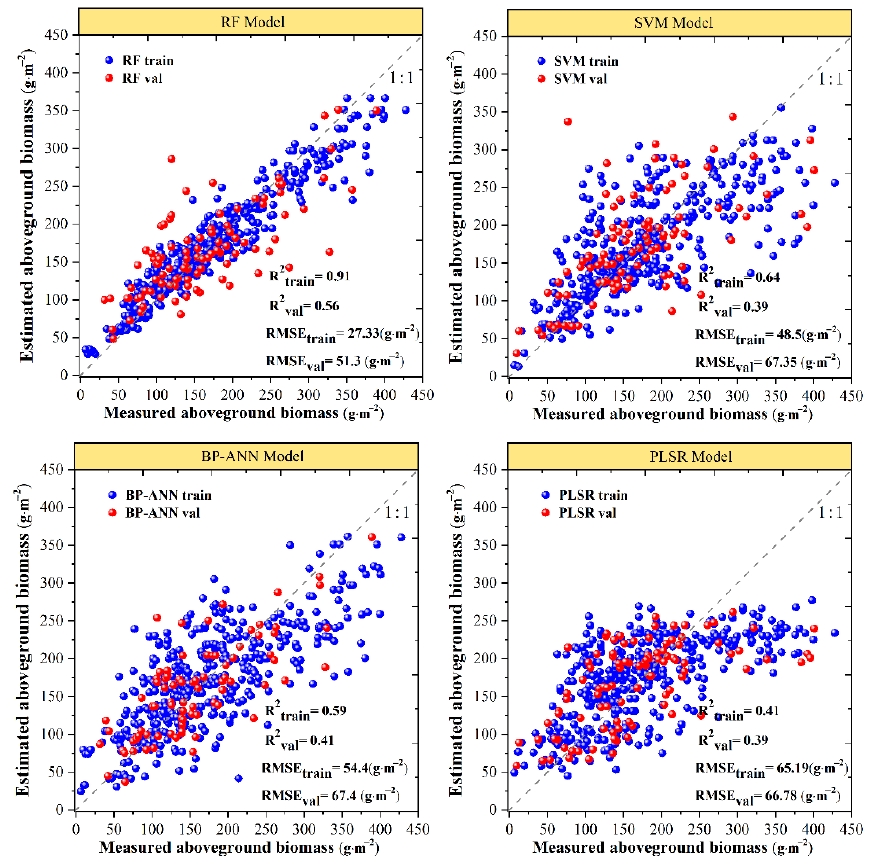
Figure 4. Accuracy evaluation of AGB simulated by different simulation methods.